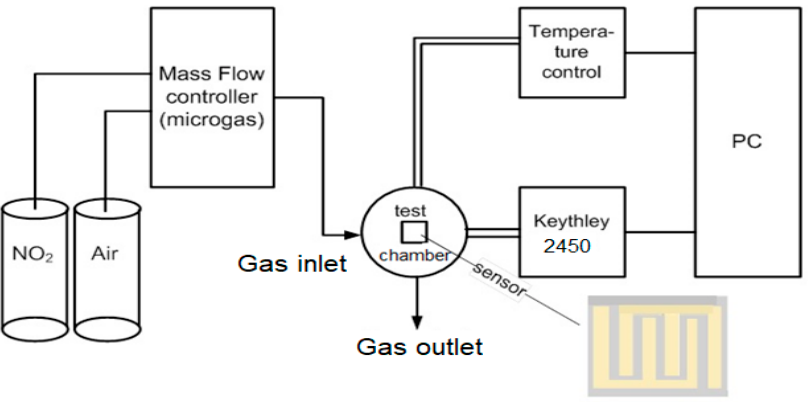
Figure 1. Schematic diagram of the measurement setup.